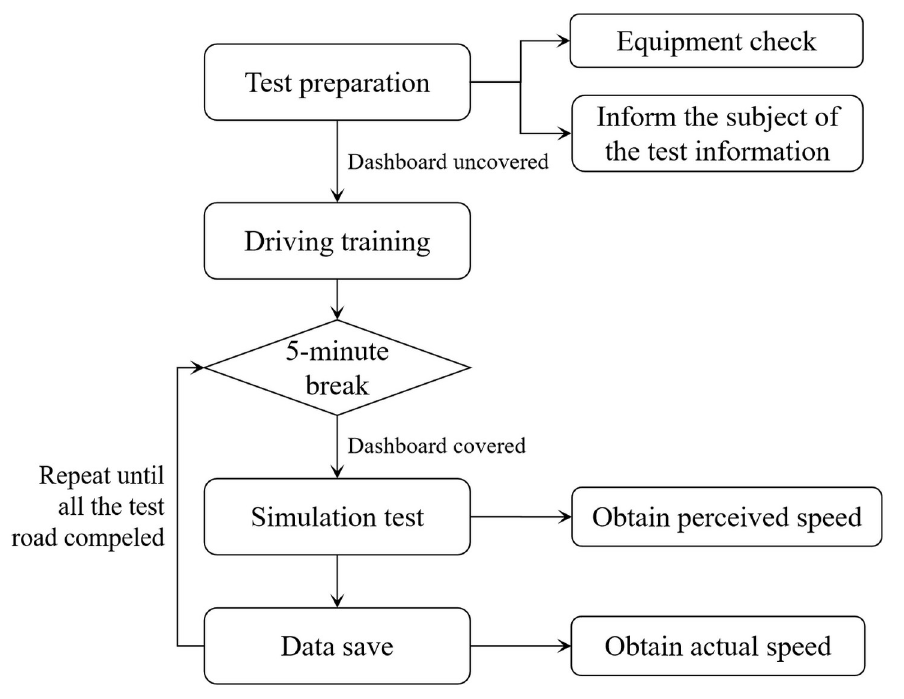
Fig 8. Validation test process (simulation test).